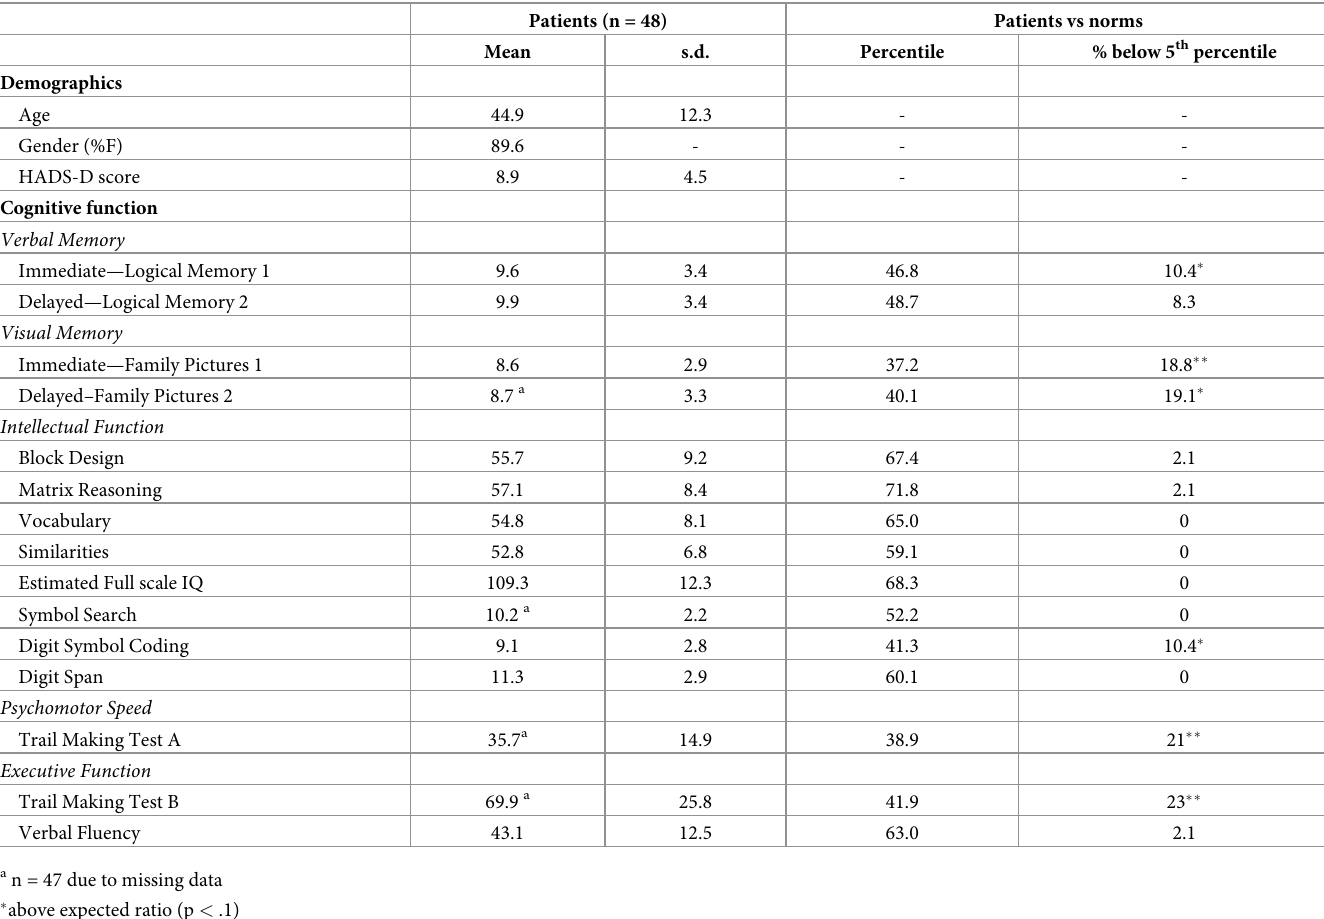
Table 1. Phase 1 demographics and neuropsychological test